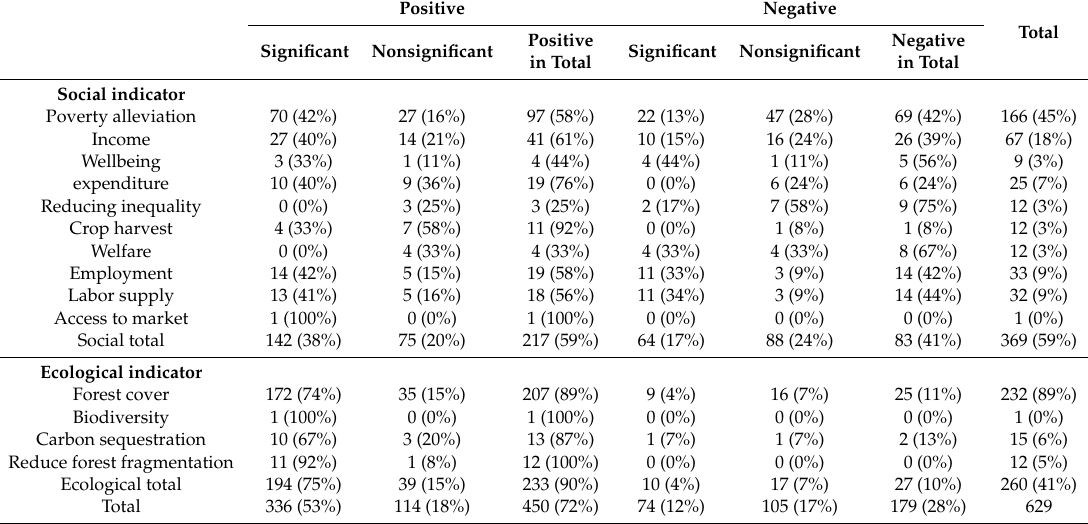
Table 1. Descriptive analysis of the evaluation results of the establishment of protected